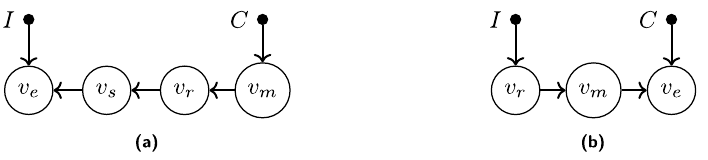
Figure 10: Equilibrium Markov ordering graphs of the protein signalling pathway with the context variable C included, corre - sponding to two hypothetical models. This context variable indicates whether a cell was treated with a MEK inhibitor or not. ( a ) Perfectly adaptive model ( with feedback ) . ( b ) Causal Bayesian network